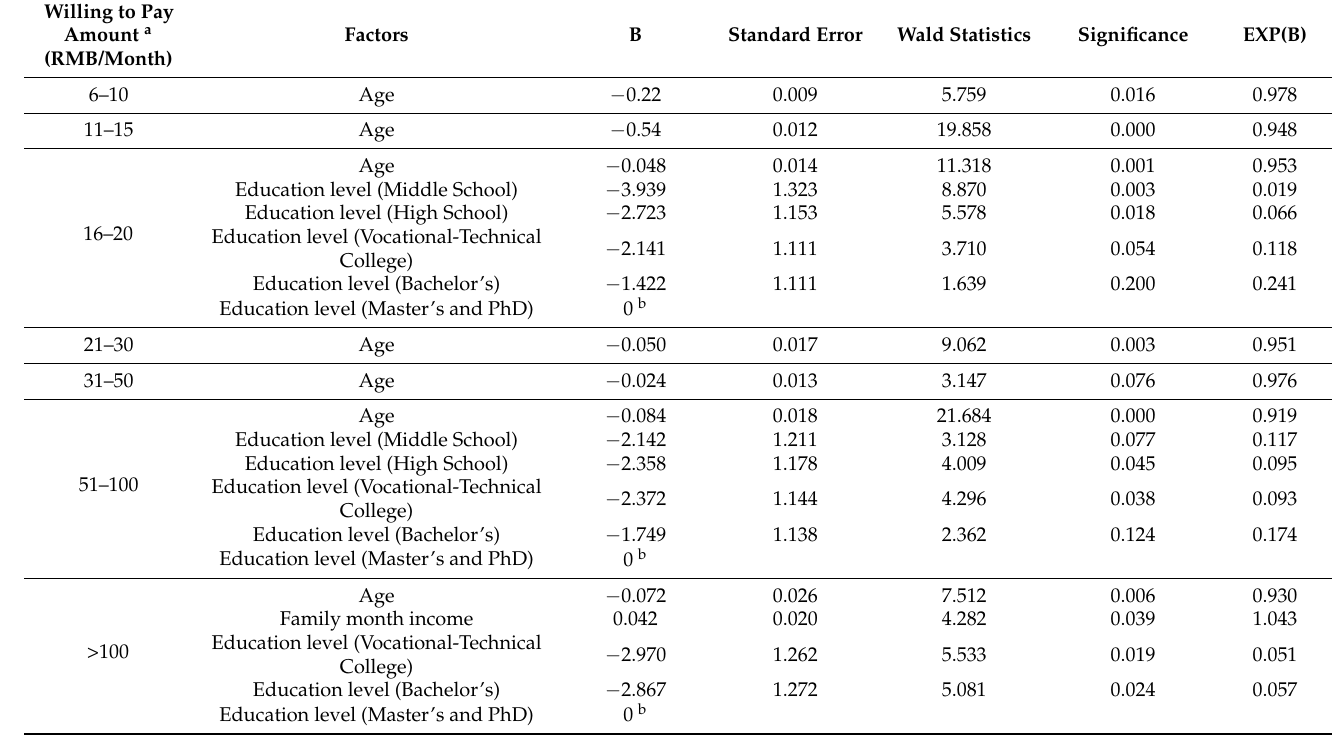
Table 3. Results of factors influencing the amount respondents are willing to